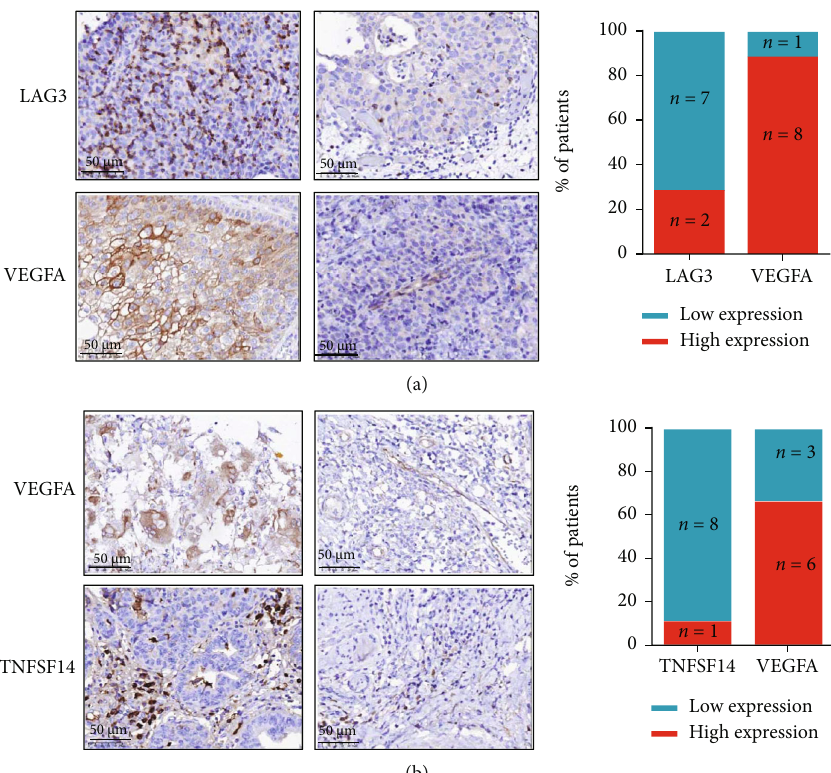
Figure 3: IHC of di ff erentially expressed immune-related genes before and after neoadjuvant chemotherapy. The tumor tissues from patients before neoadjuvant chemotherapy were stained for (a) LAG3 and VEGFA and, after neoadjuvant chemotherapy, were stained for (b) VEGFA and TNFSF14. Magni fi cations: ×